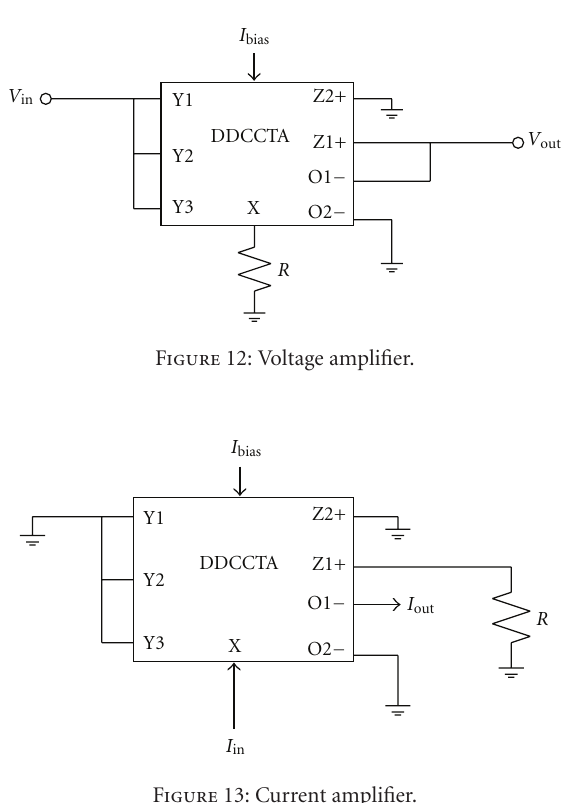
Figure 13: Current